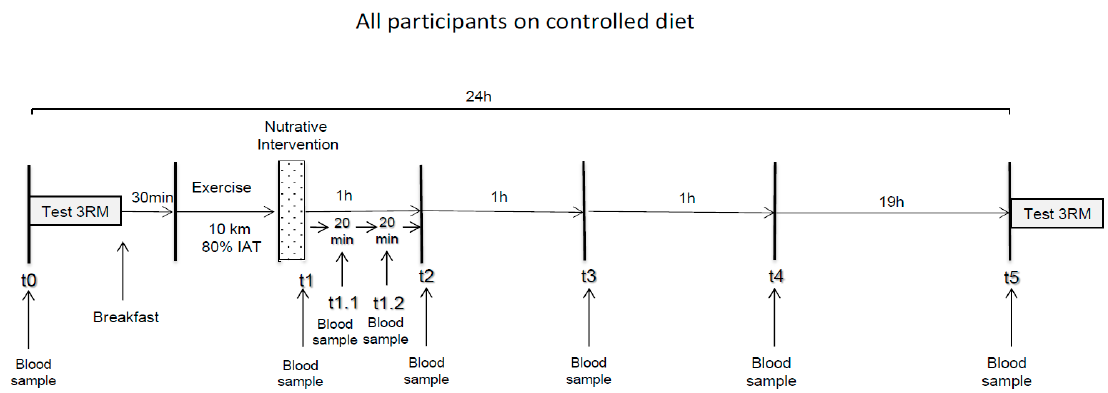
Figure 1. Experimental design of the study. IAT = individual anaerobic threshold. 3RM = leg strength.